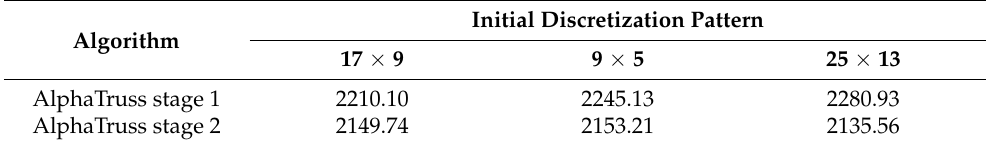
Table 14. Minimum weights (kg) of trusses with different grid